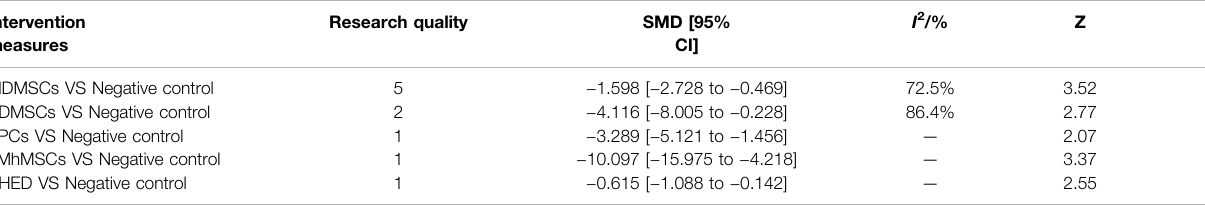
TABLE 13 | Traditional Meta-analysis results of histological scores between stem cell groups and the control group in early stage after administration. Intervention measures